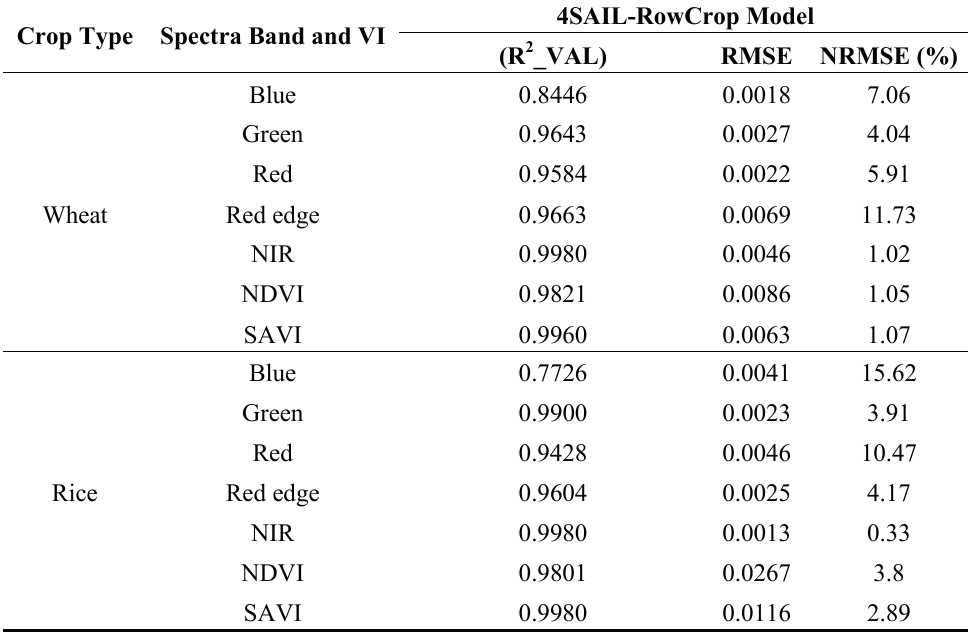
Table 12. Correlation of the simulated nadir direction reflectance spectra determined using the 4SAIL-RowCrop with field